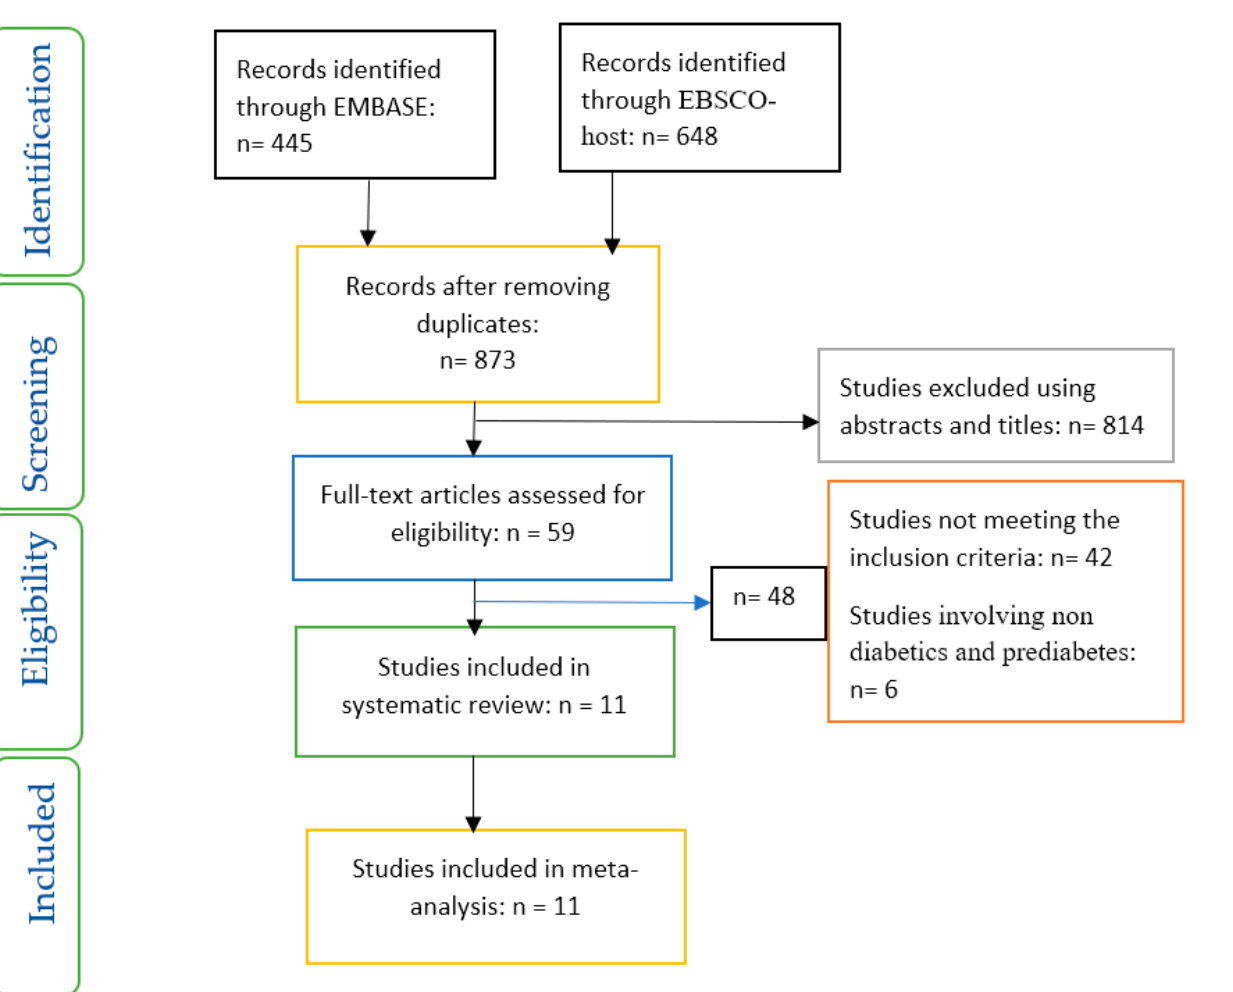
Figure 1. PRISMA flow chart on selection and inclusion of studies.